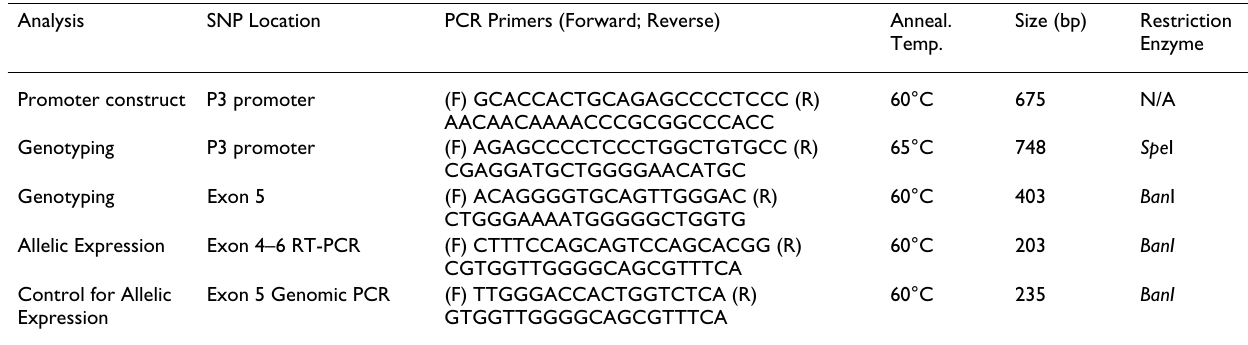
Table 1: PCR conditions and primers for analyzing TP73 SNPs Analysis SNP Location PCR Primers (Forward;